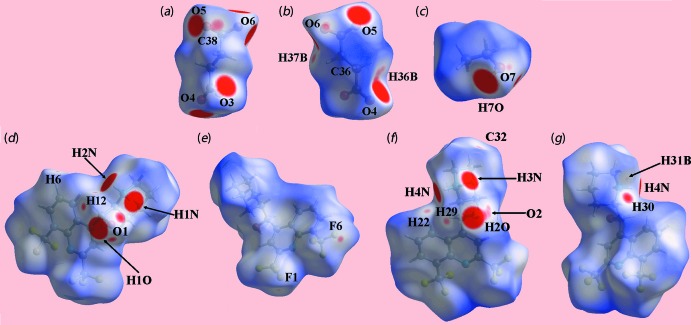
Views of the Hirshfeld surface of (I) mapped over d
norm for the: (a) and (b) dianion in the range −0.229 to + 1.450 arbitrary units (a.u.), (c) ethanol mol­ecule (−0.169 to +1.471 a.u.), (d) and (e) O1-containing cation (−0.229 to + 2.242 a.u.) and (f) and (g) O2-containing cation (−0.219 to +2.159 a.u.).